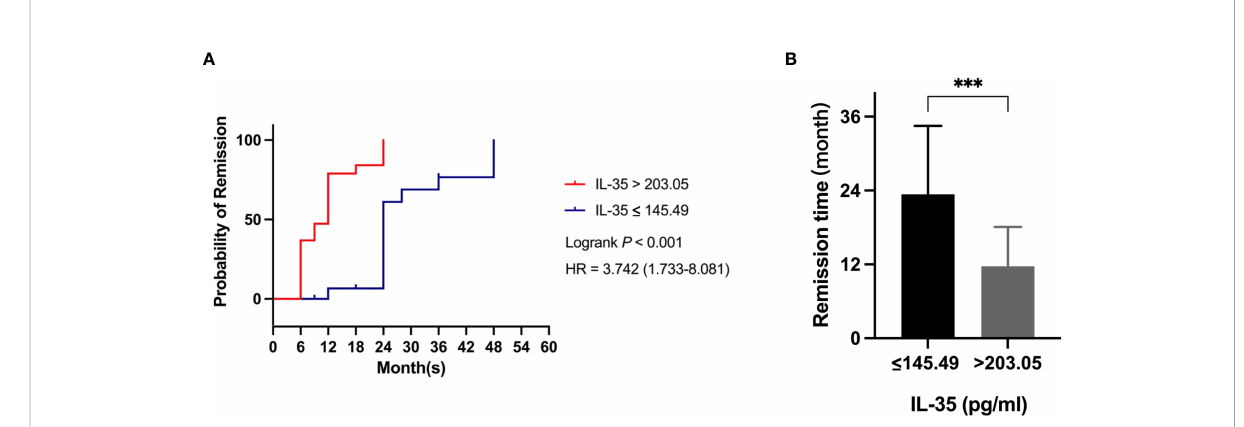
FIGURE 4 Comparison of remission time of IMN patients with different baseline IL-35 levels. (A) Kaplan-Meier analysis was used to assess the remission time between IMN patients of serum IL-35 ≤ 145.49pg/ml (blue line) (n=18) with that of >203.05pg/ml (red line) (n=19). (B) Comparison of median remission time between IMN patients of serum IL-35 ≤ 145.49pg/ml with that of >203.05pg/ml. *** represent P <0.001.